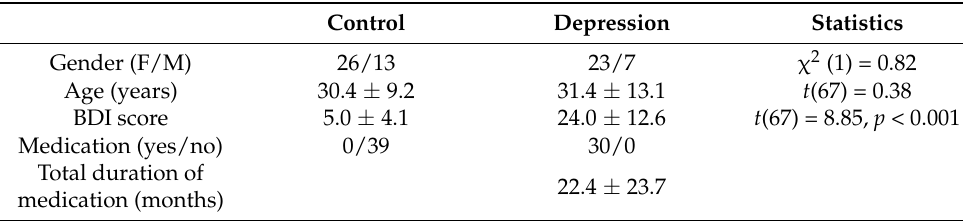
Table 1. Demographic and clinical characteristics of participants (mean ± SD). Control Depression